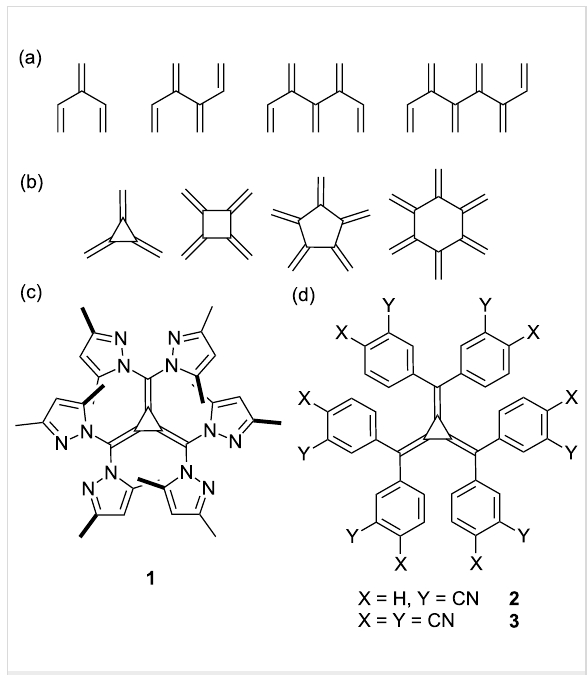
Figure 1: The structures of a) the parent [3]-, [4]-, [5]-, and [6]dendralenes and b) the corresponding radialenes. The structure of c) hexakis(3,5-dimethylpyrazolyl)[3]radialene ( 1 ) and d) hexakis(3- cyanophenyl)[3]radialene ( 2 ) and hexakis(3,4-dicyanophenyl)[3]radia- lene ( 3